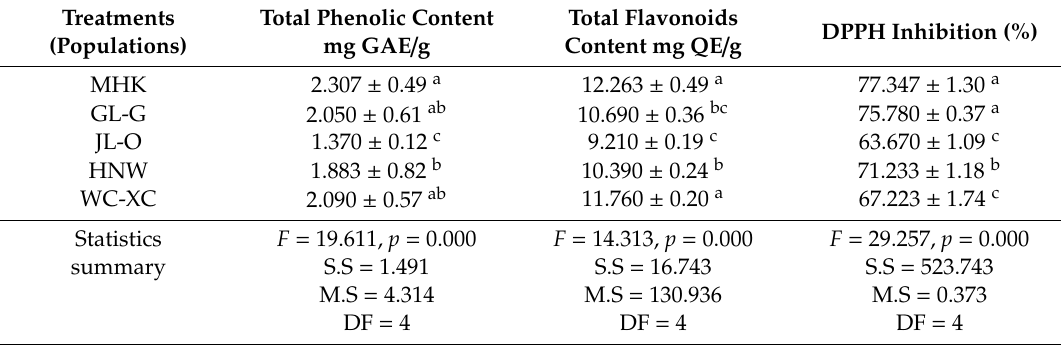
Table 2. Total phenolic content (TPC), total flavonoids content (TFC) and DPPH radical scavenging activity of S. trifolia